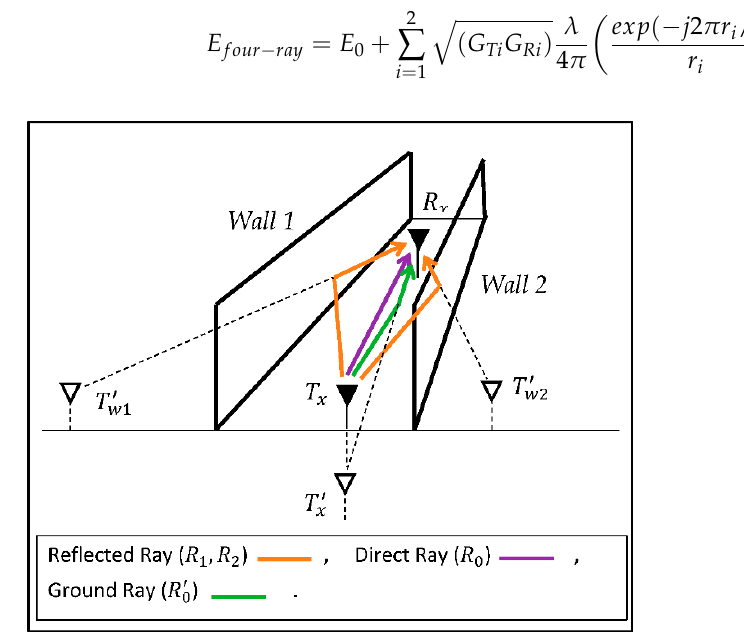
Figure 4. The four-ray model.